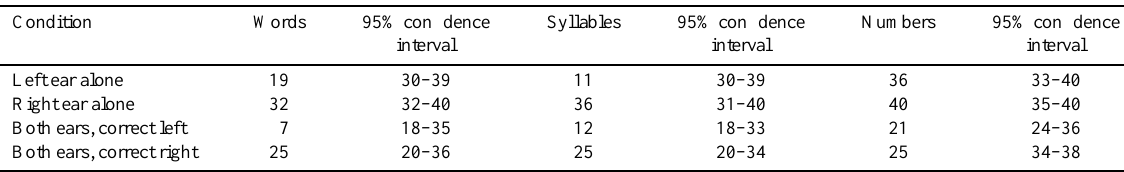
Table 3 Dichotic listening experiment